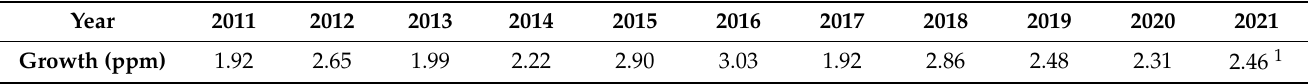
Table 1. Mean annual CO 2 growth rates (ppm y − 1 ) for Mauna Loa for the last decade from 2011 through 2021